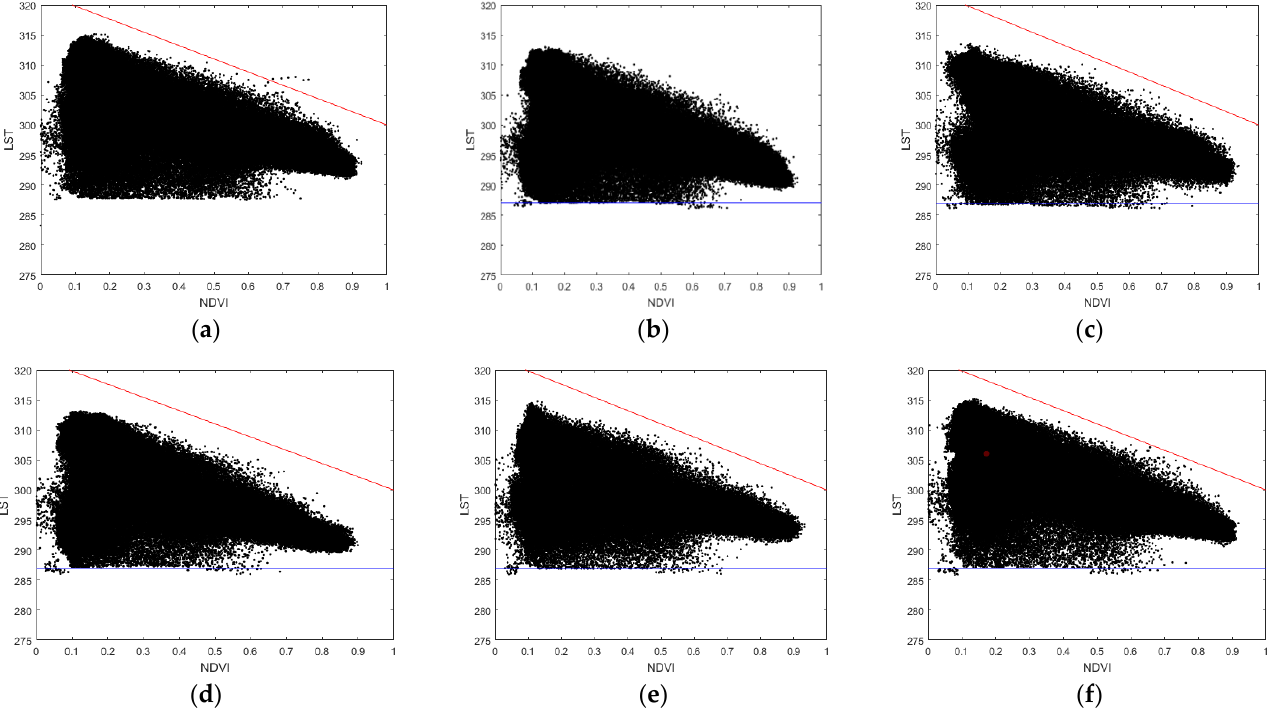
Figure 2. Scatterplots of LST and NDVI in the first 16 days of February (D-041) spanning 2011 – 2014: ( a ) Determining the cold edge using the multiyear maximum value NDVI products and maximum– minimum value composite LST products. ( b ) Determining the warm edge by the multiyear maximum value composite LST and NDVI products. ( c – f ) show the WACE plotting of the single-year maximum-value composite LST and NDVI products in the first 16 days of February (D-041) for the years 2011, 2012, 2013, and 2014, respectively.